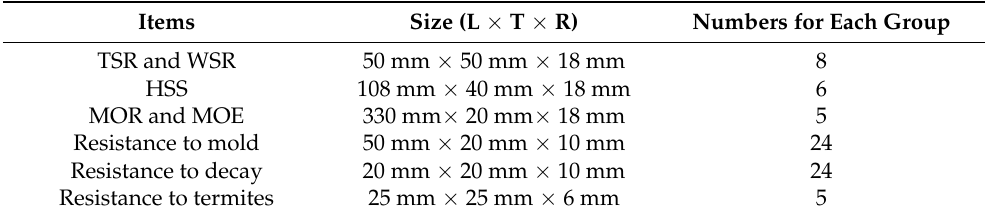
Table 2. Dimensions and numbers of BSC specimens used for physical–mechanical and durability